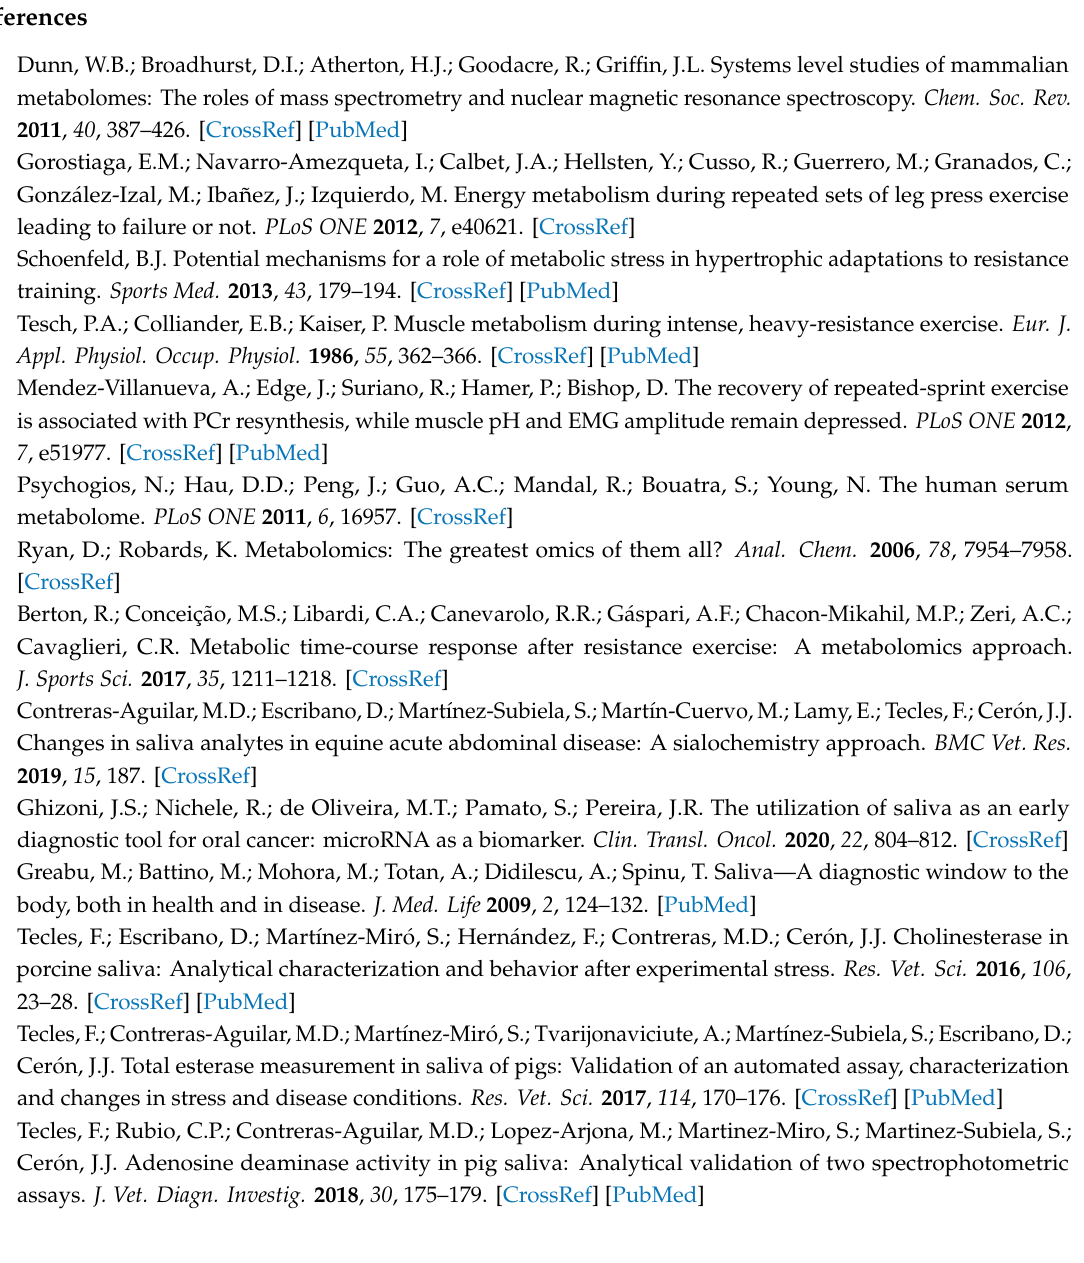
Table S1: Serum metabolites with no significant di ff erence in concentrations before and after exercise ( µ mol / L; mean ± SD), Table S2: Salivary metabolites with no significant di ff erence in concentrations before and after exercise ( µ mol / L; mean ±